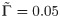
Phase diagram for Γ˜=0.05 and L = 1 showing the average density on the lattice (heat map) numerically computed via stochastic simulations, and the borders among the phases (black lines) estimated analytically within the mean-field approximation.